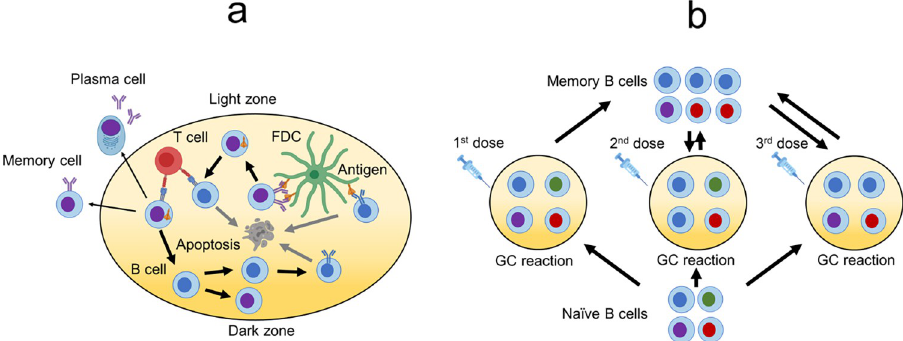
Fig 3. Overview of the affinity maturation model. (a) Schematic of AM within a GC. Activated B cells first undergo expansion and somatic hypermutation (SHM), and then they undergo selection based on their ability to bind and internalize antigen presented on FDCs and receive T cell help. A small fraction of positively selected B cells exits as antibody-secreting plasma cells and memory cells. The others undergo another round of mutation and selection. This cycle repeats until a termination condition is met. (b) Schematic of seeding new GCs upon new immunizations. For the first immunization, the seeding cells come solely from naive B cells. For subsequent immunizations, seeding cells come from both the naive and memory cell populations, and newly generated memory cells join the memory cell population. Created with BioRender.com.